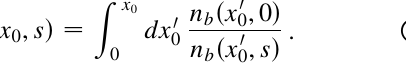
FIG. 7. Plot of layer edge location x b (cid:1) s (cid:2) (cid:1) x (cid:1) x b 0 , s (cid:2) obtained numerically from Eqs. (82)–(86) and Eq. (94) for the initial density profile in Eq. (90) and choice of system parameters in Eq. (93).